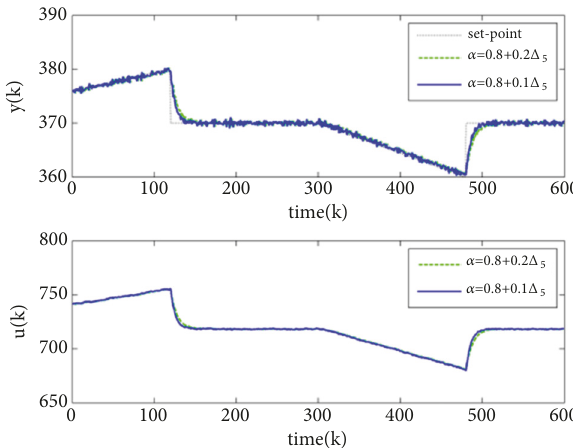
Figure 6: Output response and control input under random-varying fault.